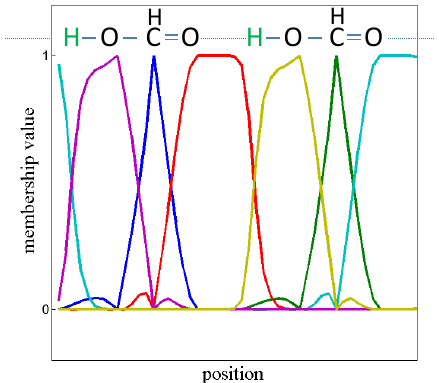
Figure 6. We applied SQRT-A to the electron density calculations of formic acid (Figure 5) in order to yield L . Via PCCA+ based on 6 Schur vectors X of L we computed the membership vectors χ = X A . The resulting membership vectors are plotted. It turns out that the CH -moiety is like a barrier for the electron density